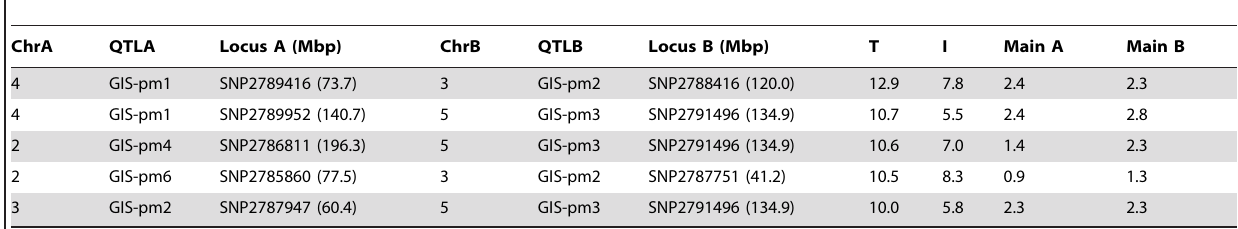
Table 2. Gene interaction analysis of GIS in postmenopausal F2 (Dahl S x R) intercross female rats.